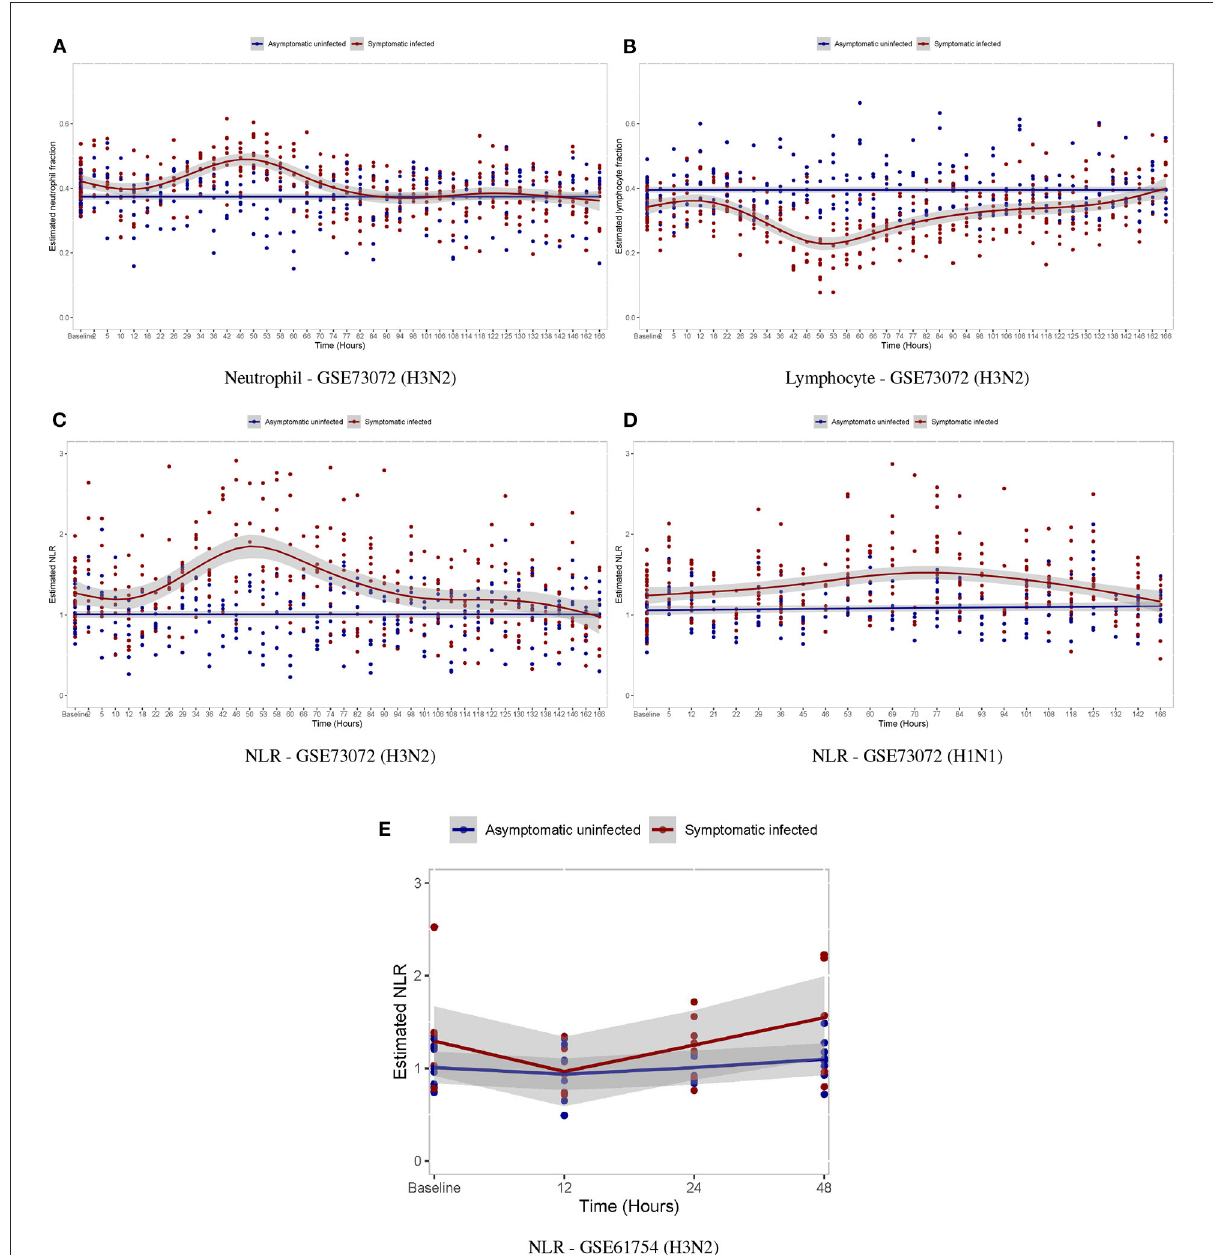
FIGURE8 Temporal changes in white blood cell proportions among volunteers after inoculation with influenza virus. (A,B) Temporal changes in neutrophil/lymphocyte proportions in the GSE73072 H3N2 cohort. (C–E) Temporal changes in NLR among individuals in three cohorts.